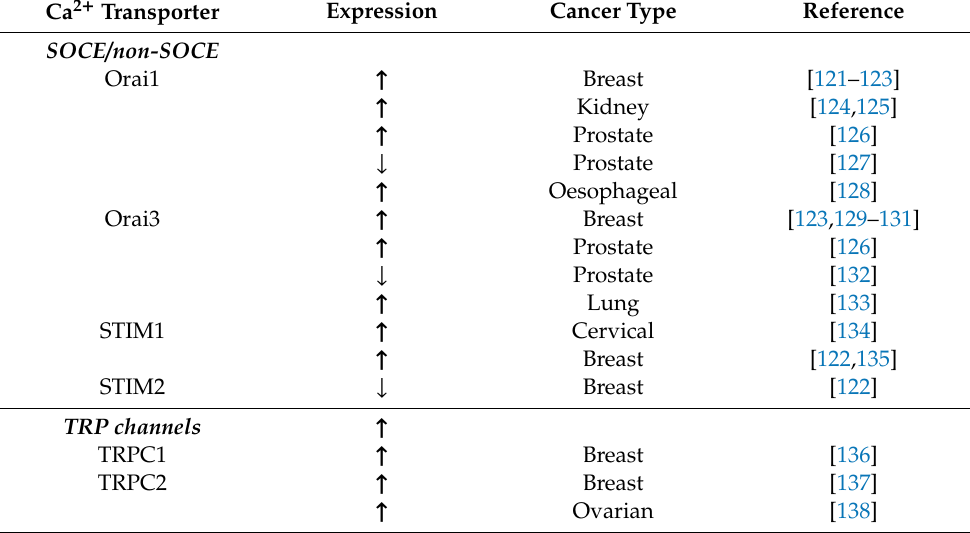
Table 1. Altered expression of components of the Ca 2 + signalling machinery during cancer. An increase or decrease in expression is indicated by the appropriate arrow. Each Ca 2 + transporter is sub-categorised into store-operated Ca 2 + channel (SOCE) / non-SOCE, transient receptor potential (TRP) channels, Ca 2 + ATPases, and Ca 2 + release channels. STIM, stromal interacting molecule; TRPV, TRP vanilloid; TRPM, TRP